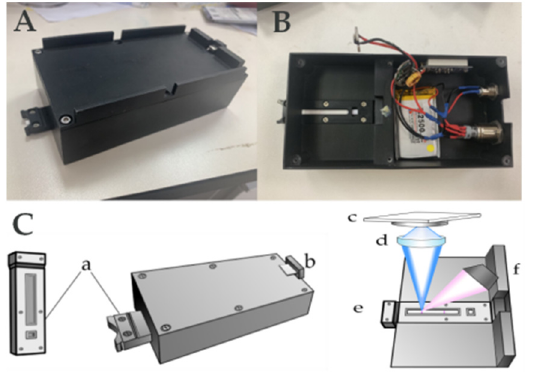
Figure 1. ( A ) The external view of iPOCT reader; ( B ) top view of iPOCT reader; ( C ) schematic illustration of the POCT reader: (a) test strip slot, (b) 3-in-1 data cable (type-c, lightning, and micro-USB), (c) photodiode, (d) filter, (e) UV light (365 nm), and (f) test strip slot.